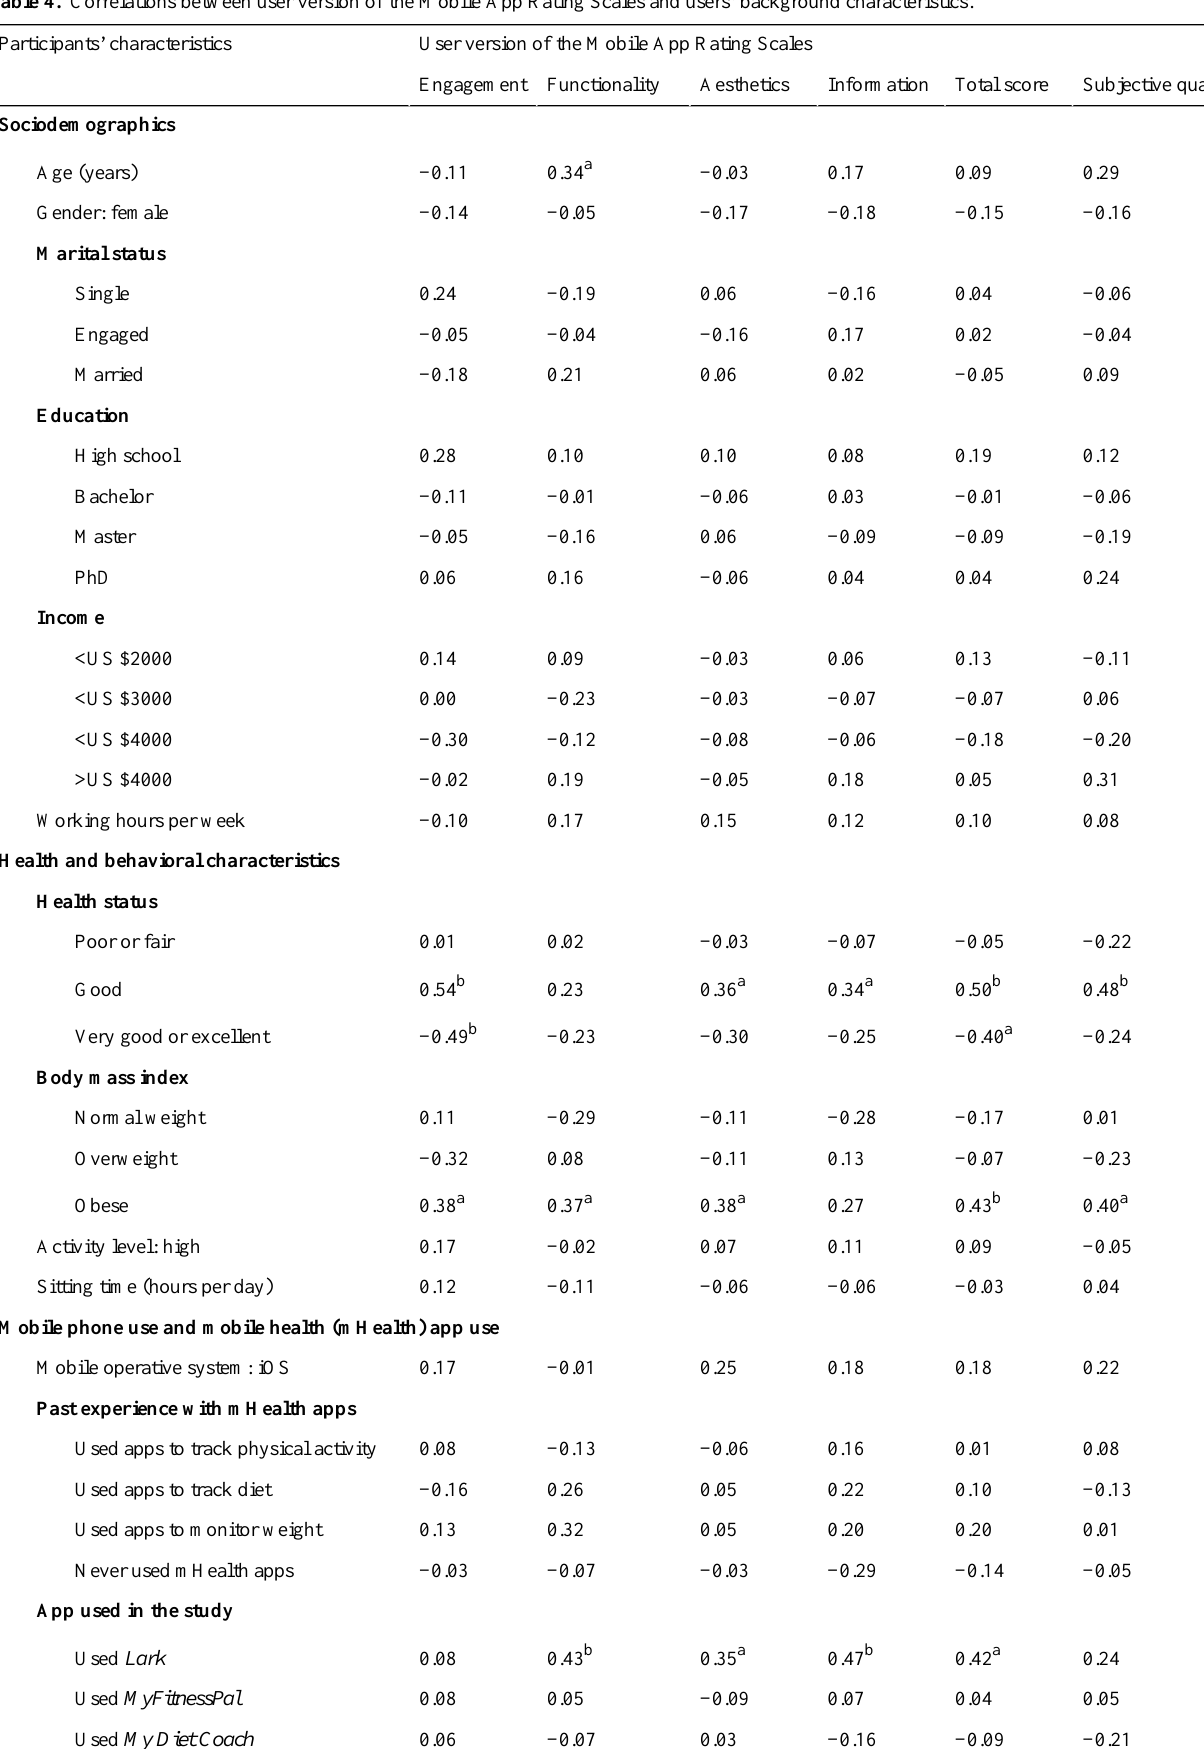
Table 4. Correlations between user version of the Mobile App Rating Scales and users’background characteristics. User version of the Mobile App Rating